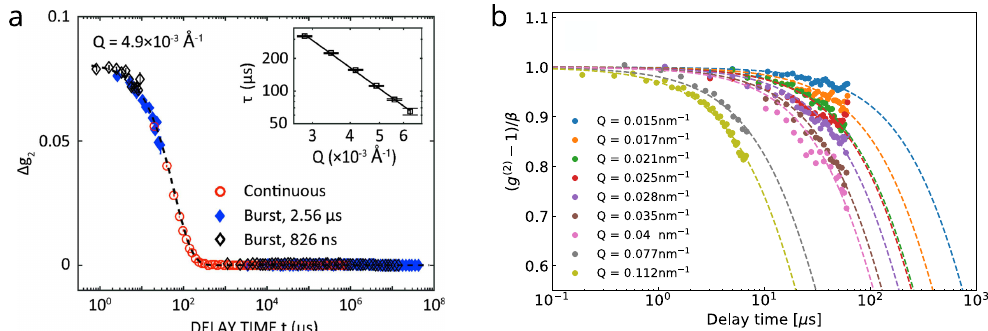
Figure 9. MHz XPCS from diffusion of silica nanoparticles in water at ( a ) beamline 8-ID of APS using a prototype of the XSPA detector [81] and ( b ) beamline P10 of PETRA III using AGIPD [35]. The inset in panel a shows the relaxation time as function of q , the solid line is a fit with the slope of − 2. Figure from [81] reproduced with permission of the International Union of Crystallography, figure from [35] reproduced under CC-BY